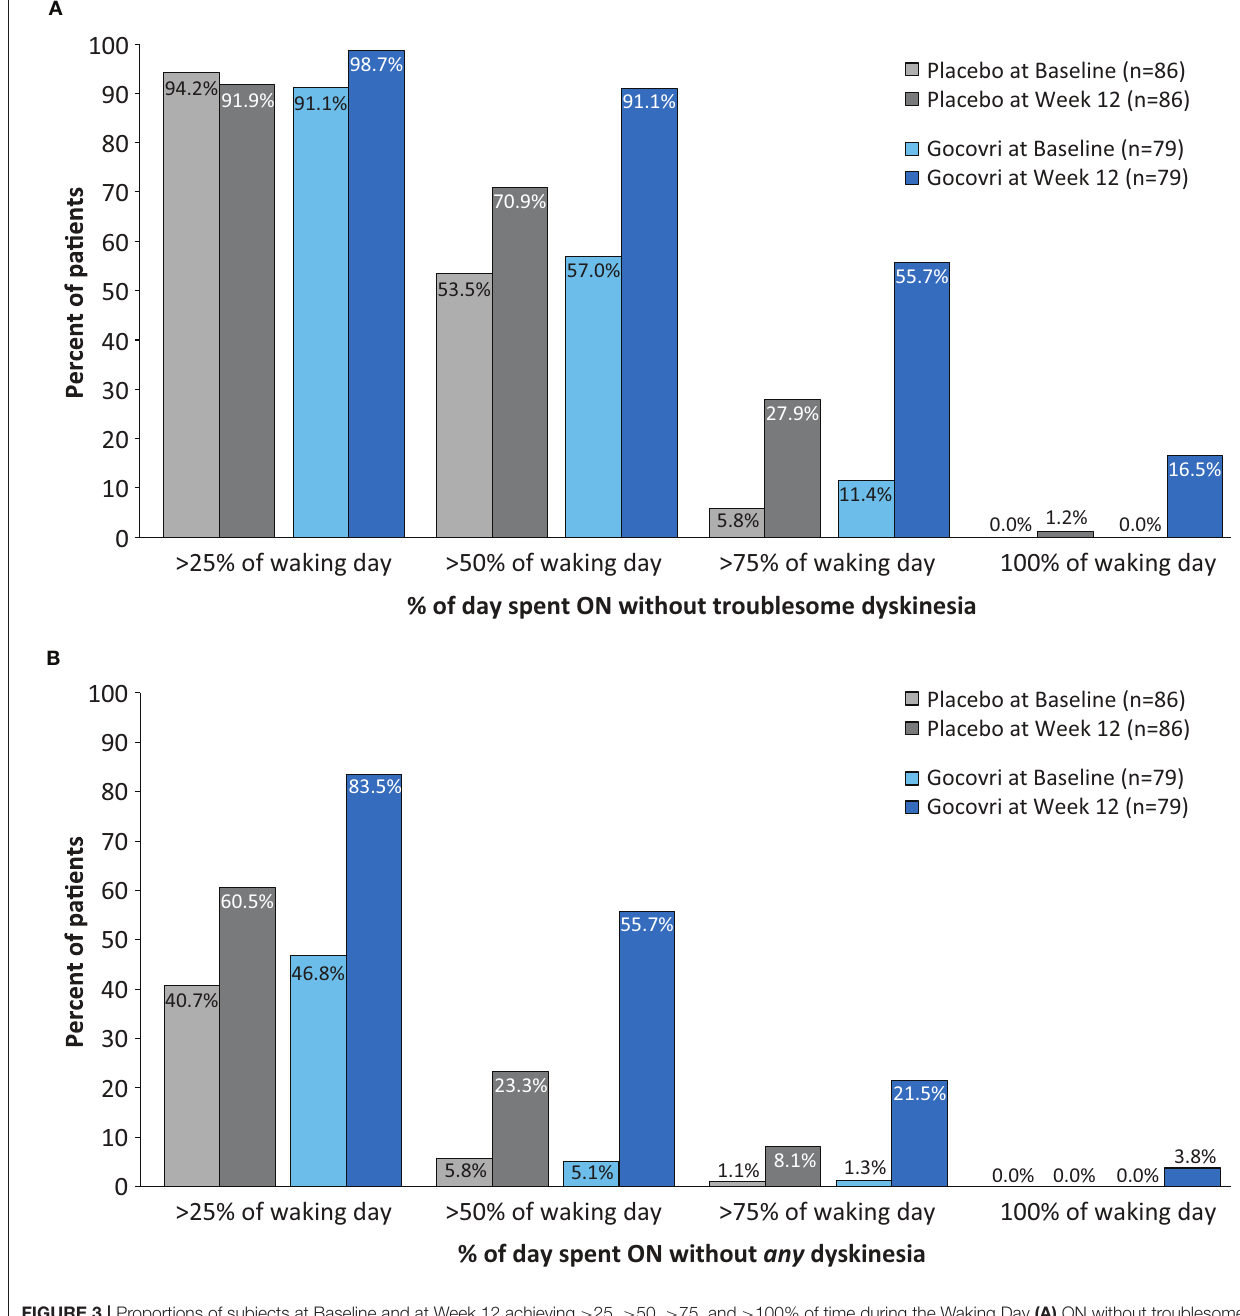
FIGURE 3 | Proportions of subjects at Baseline and at Week 12 achieving > 25, > 50, > 75, and > 100% of time during the Waking Day (A) ON without troublesome dyskinesia ( p < 0.001 favoring Gocovri vs. placebo) (B) ON without (troublesome or non-troublesome) dyskinesia. ( p = 0.003 favoring Gocovri vs. placebo). Two-sided p -values comparing Gocovri vs. placebo in terms of the frequency distribution of shifts from baseline to week 12 (where each shift was categorized in one of nine ordered classes representing levels of improvement, worsening, or no change, were obtained using the Cochran-Mantel-Haenszel chi-squared test. The frequency distribution for the shifts was determined by using the cross-classification of subjects at baseline and at week 12 with % of time of 25, 50, 75 and 100%. The baselines for all subjects [N = 96 placebo and N = 100 Gocovri] were: A) > 25%: 94.8% and 93.0%; > 50%: 55.2% and 57%; > 75%: 6.3% and 12.0%; 100% none B) > 25%: 40.6% and 46.0%; > 50%: 6.3% and 5.0%; > 75%: 1% and 1%; 100%